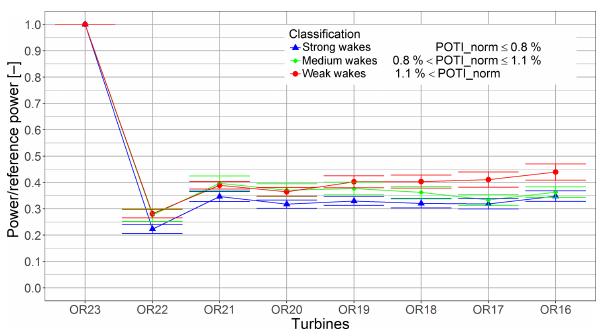
Figure 18. Normalised power for each turbine along the row be- hind OR23 for a wind direction of 312 ◦ , a 10 ◦ sector width and 8ms − 1 ± 1. Stability classes distinguished with the signal PO TI from